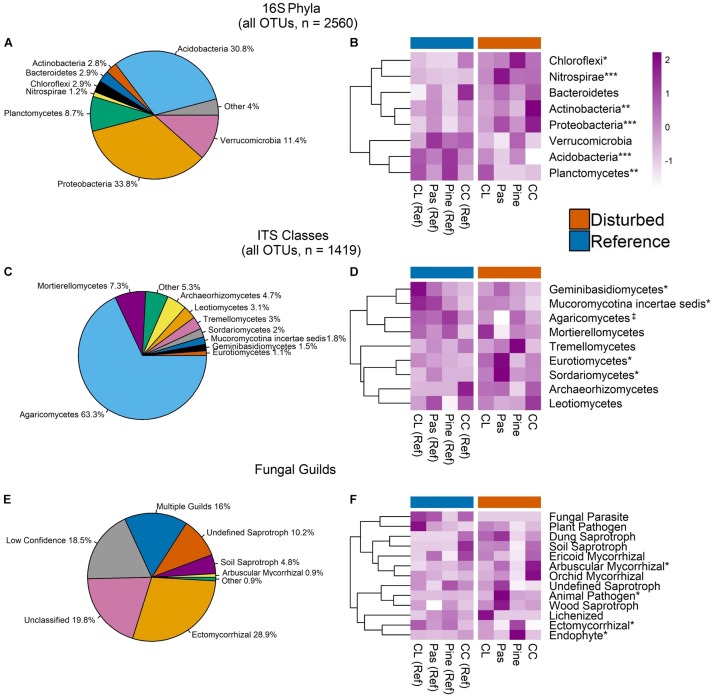
Pie charts display relative abundance of bacterial phyla (A), fungal classes (C), and fungal guilds (E) aggregated across all OTUs in all samples. Only phyla/classes comprising >1% of sequences and guilds comprising >0.9% of sequences are shown. Heat maps in panels B, D, and F show scaled Z-scores for relative abundances for each bacterial phylum (C), fungal class (D), and fungal guild (F) across each watershed. CC, clear-cut; CL, cable-logged; Pas, pasture conversion; Pine, pine conversion. Symbols represent statistical significance at the following levels: ∗∗∗P < 0.001, ∗∗P < 0.01, ∗P < 0.05, ‡P < 0.1. P-values are the main effects of disturbance from two-way ANOVA. Dendrograms on heat maps reflect similarity of relative abundance patterns of taxa across watersheds (complete-linkage clustering) and do not reflect phylogenetic relationships.